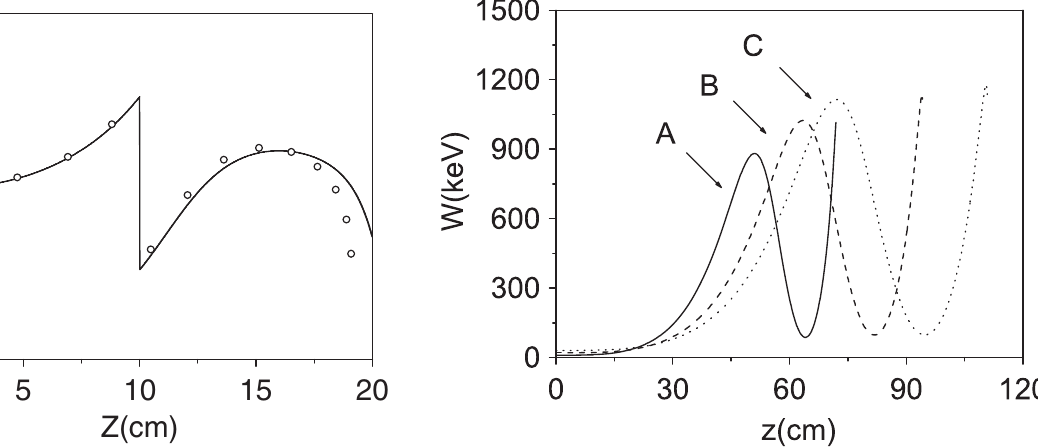
FIG. 6. Dependence of the phase shift on the longitudinal coordinate: the solid line is the SARA model; the circles repre- sent data obtained in Ref. [13].